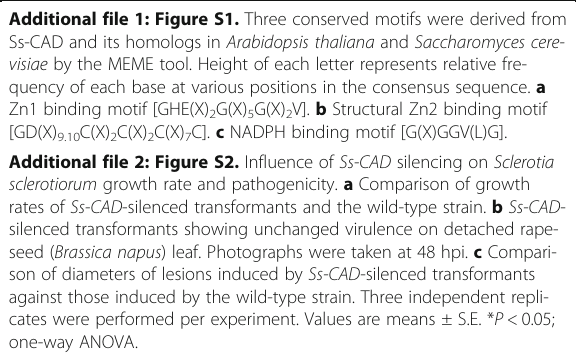
Additional file 1: Figure S1. Three conserved motifs were derived from Ss-CAD and its homologs in Arabidopsis thaliana and Saccharomyces cere- visiae by the MEME tool. Height of each letter represents relative fre- quency of each base at various positions in the consensus sequence. a